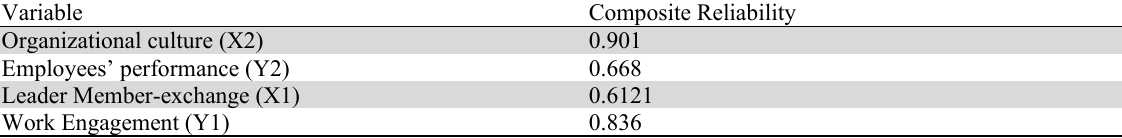
Composite Reliability Result of each Variable Variable